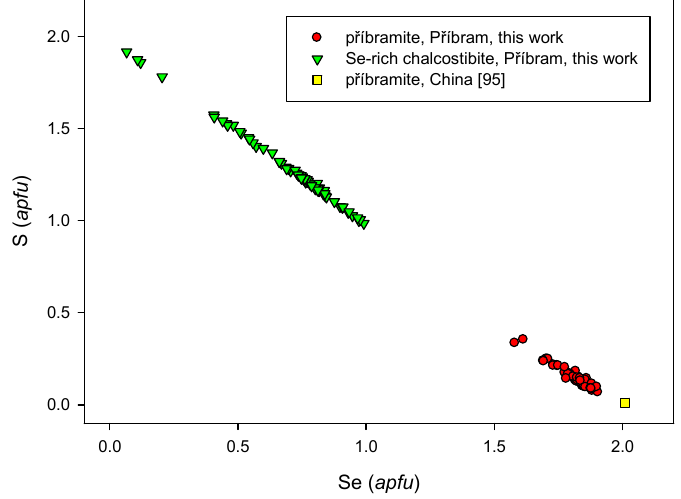
Figure 46. Se vs. S ( apfu ) graph for p ř íbramite and Se-rich chalcostibite from P ř íbram and China.